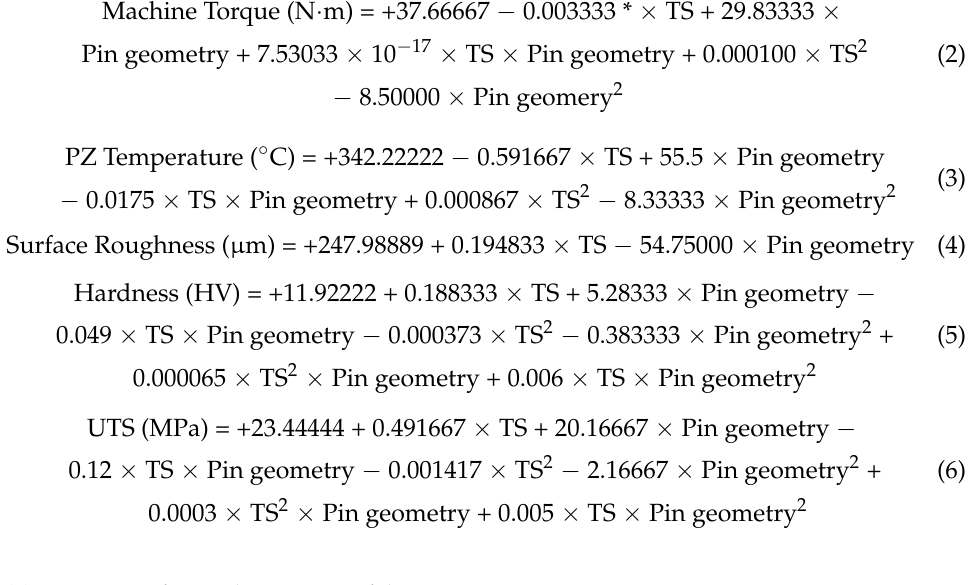
Table 4. ANOVA for machine torque of the AA1050 BT-FSP